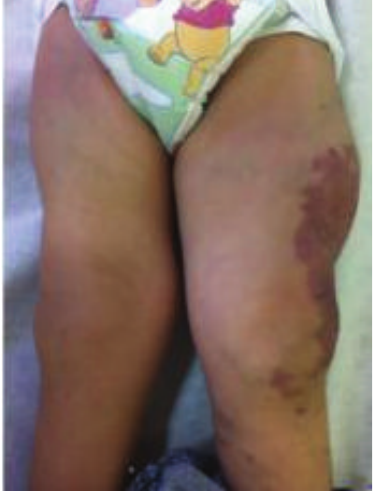
Figure 4: Hypertrophy of the left